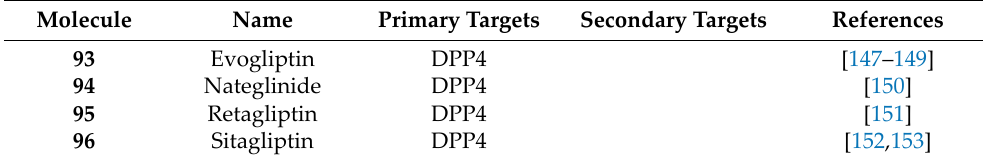
Figure 11. 2-Phenylethyl-based DPP4 receptor ligands. Table 4. Dopamine receptor medicinal chemistry leads.